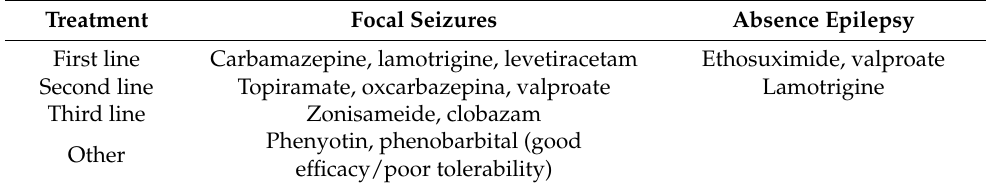
Table 2. Treatment choice in monotherapy for seizures in